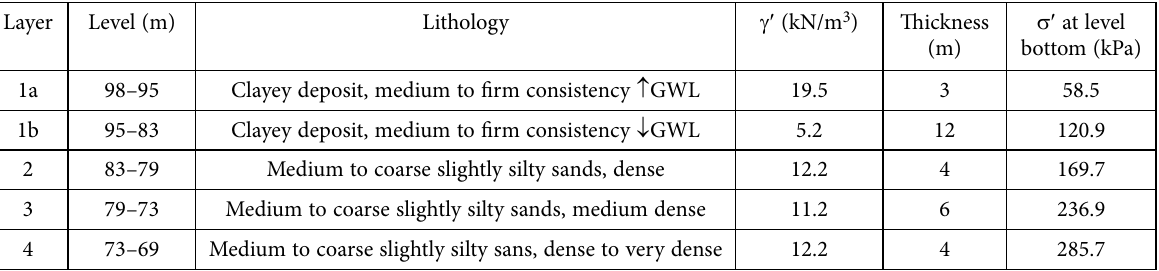
Table 2. Overburden earth pressure at the pile